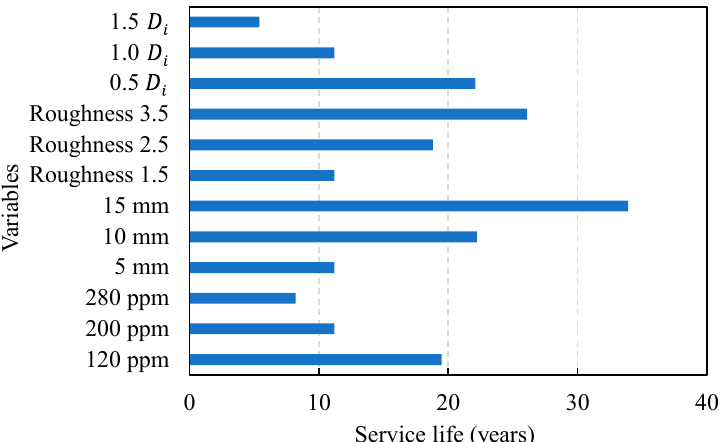
Figure 10. Changes in service life with design variables. Based on the design constants for actual construction, if the change ratio with reference to the baseline value (average) of each design parameter can be illustrated, the effect of each parameter on the service life can be quantitatively evaluated. The changes in service life gradient with respect to the baseline conditions (exterior sulfate concentration, 200 ppm; coating thickness, 5.0 mm; surface roughness, 1.5; and D i , 1.0) are depicted in Figure 11. The exterior sulfate concentration and diffusion coefficient show almost the same effect, and surface roughness and coating thickness have a relatively large effect. That is, surface roughness has a close relationship with the strength between the aggregate and the base concrete, and cover depth is also a primary mechanism to block the direct deteriorating factors from the outside, and therefore, the careful determination of the two design parameters is required for securing performance during service life.